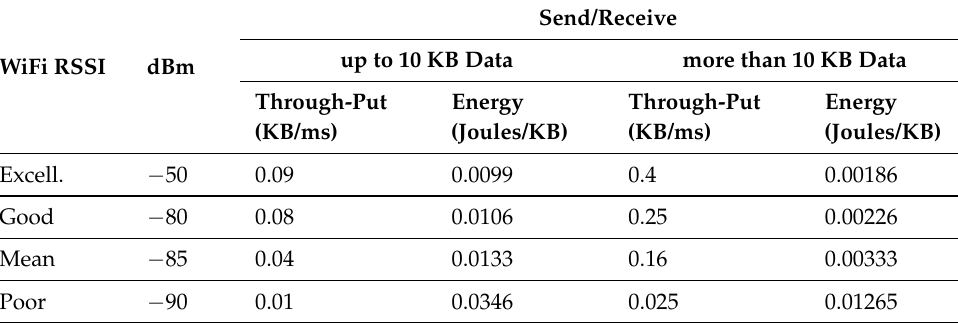
Table 2. Communication-related node-level